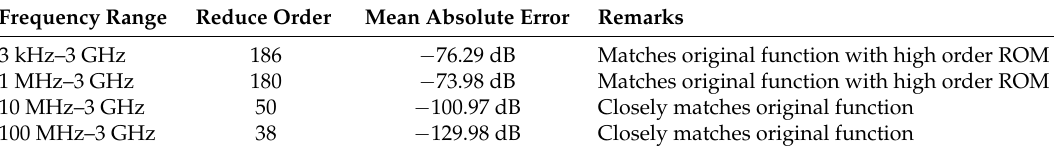
Figure 20. Absolute error of ROM generated using RNSZ of order N = 186 compared to original system frequency response of a spiral inductor (order n = 191). The mean absolute error is − 76.29 dB from 3 kHz to 3 GHz frequencies. Table 2. Comparison of spiral inductor example (Figure 12 with original system order n =